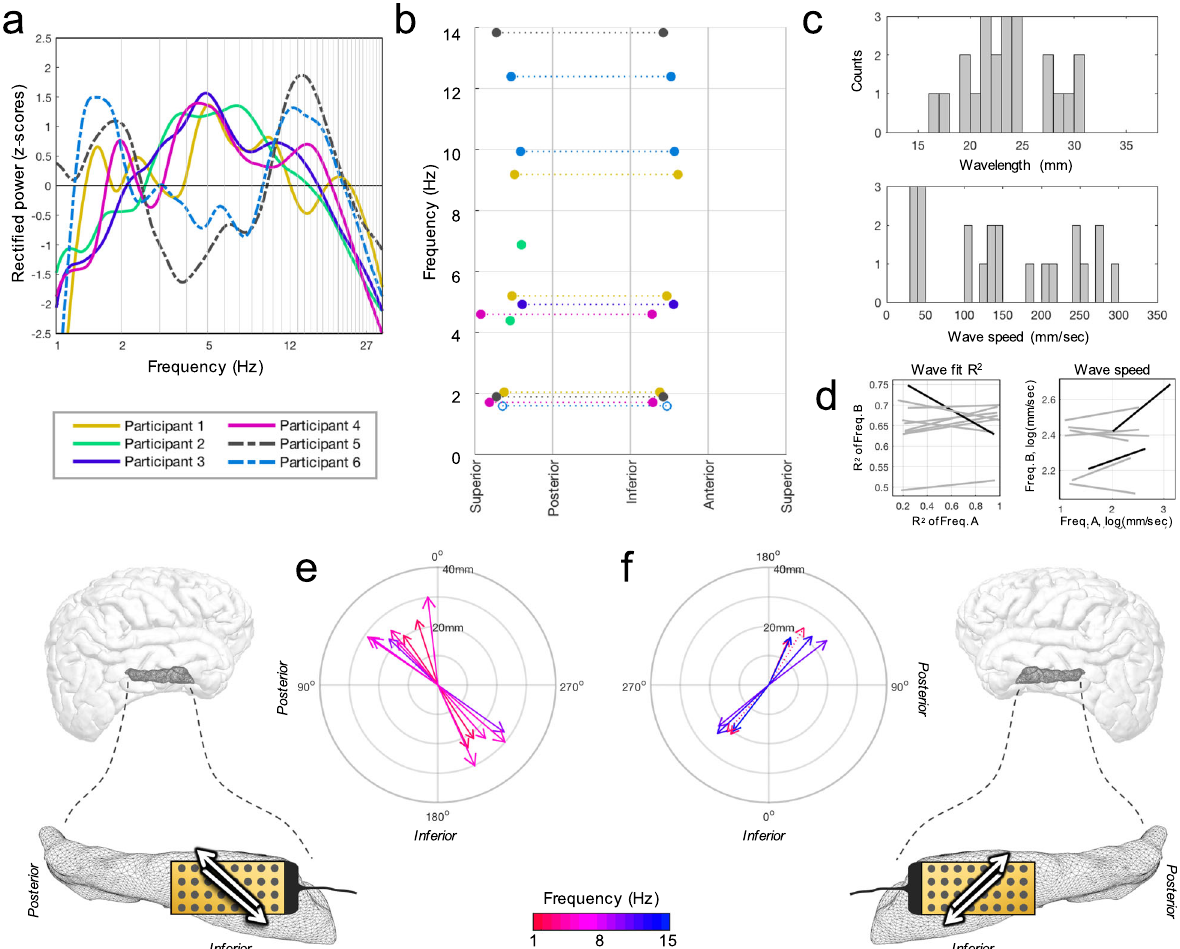
Fig. 2 Propagating hippocampal oscillations among all participants. a Recti fi ed power spectra as channel means for each participant. Awake participants (left-sided; dotted lines) appeared to have stronger power in delta and alpha ranges while theta appeared stronger in anesthetized patients (right-sided). b Direction versus frequency among all participants with consolidated anatomic orientation. Dotted lines connect each bidirectional frequency (open circles: n.s., Hodges-Ajne test). c Distributions of wavelengths (top) and speeds (bottom) for all modal directions averaged across baseline periods. d Least squares lines (gray) are shown for Spearman correlations of wave fi t ( R 2 , left panel) and speed (right panel) for any two frequencies in the same participant (9 possible combinations; see Supplementary Table 3). Signi fi cant combinations (black; >99% CI) were uncommon. e TW predominant directions (arrows) for all uni- and bidirectional instances among right-sided participants (color: center frequency, length: wavelength). Supero-posterior and infero- anterior directions predominated, depicted as white arrows in the adjacent schematic (connector orientation in black). f Similar for left-sided participants, appearing anatomically mirrored between the hemispheres (compare to ( e